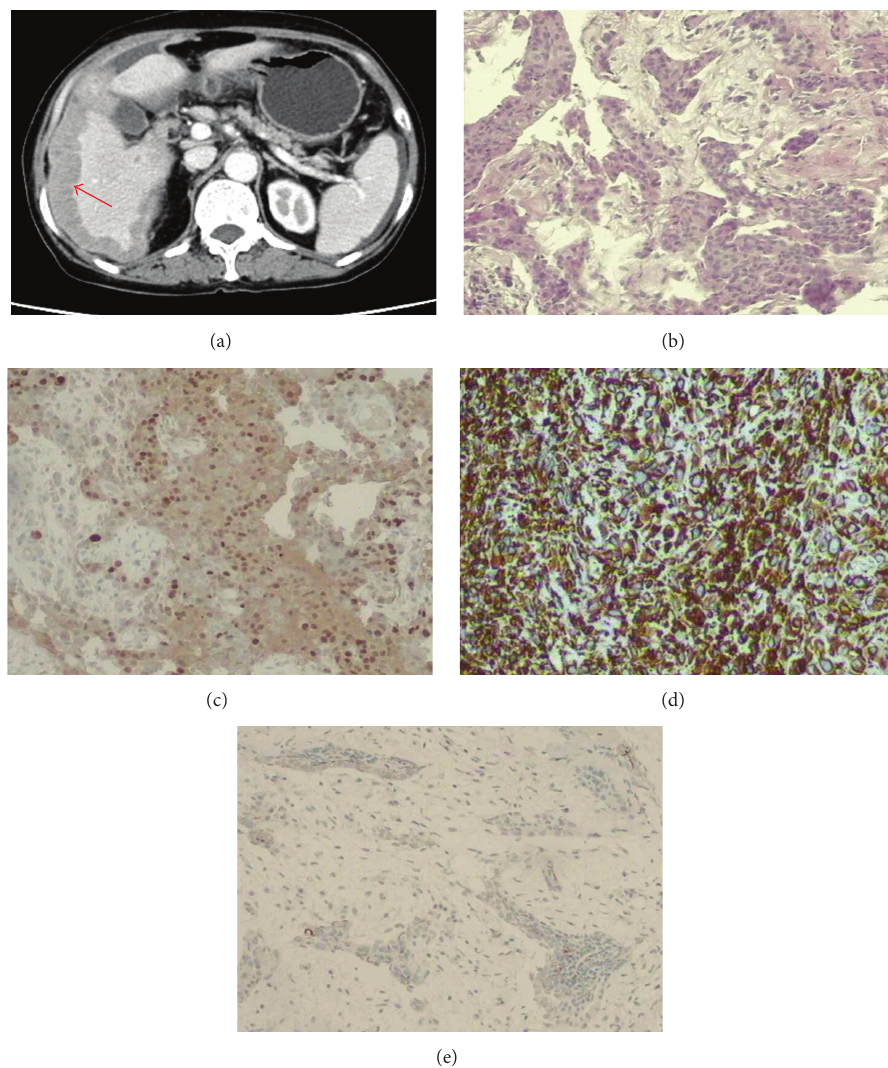
Figure 5: Abdominal CT and cytohistological features on H&E-stained specimens or immunohistochemical stains for case 5. (a) Abdominal enhanced CT revealed nonuniform thickening of peritoneum around the liver with associated invasion in liver (red arrows). (b) Cytohistological features of the peritoneum biopsy on H&E-stained specimens. Immunohistochemical stains showed that the tumour cells were positive for calretinin (c) and mesothelial cell antibody (d) but negative for carcinoembryonic antigen